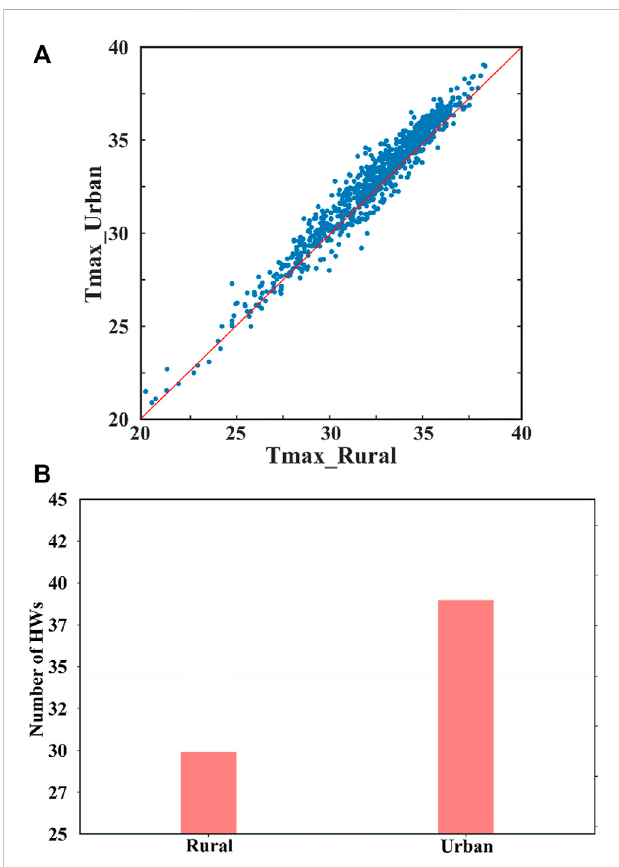
FIGURE 2 (A) Average daily maximum temperature at urban and rural stations during study period, and (B) average number of Heat Waves and UHII at urban and rural stations during study